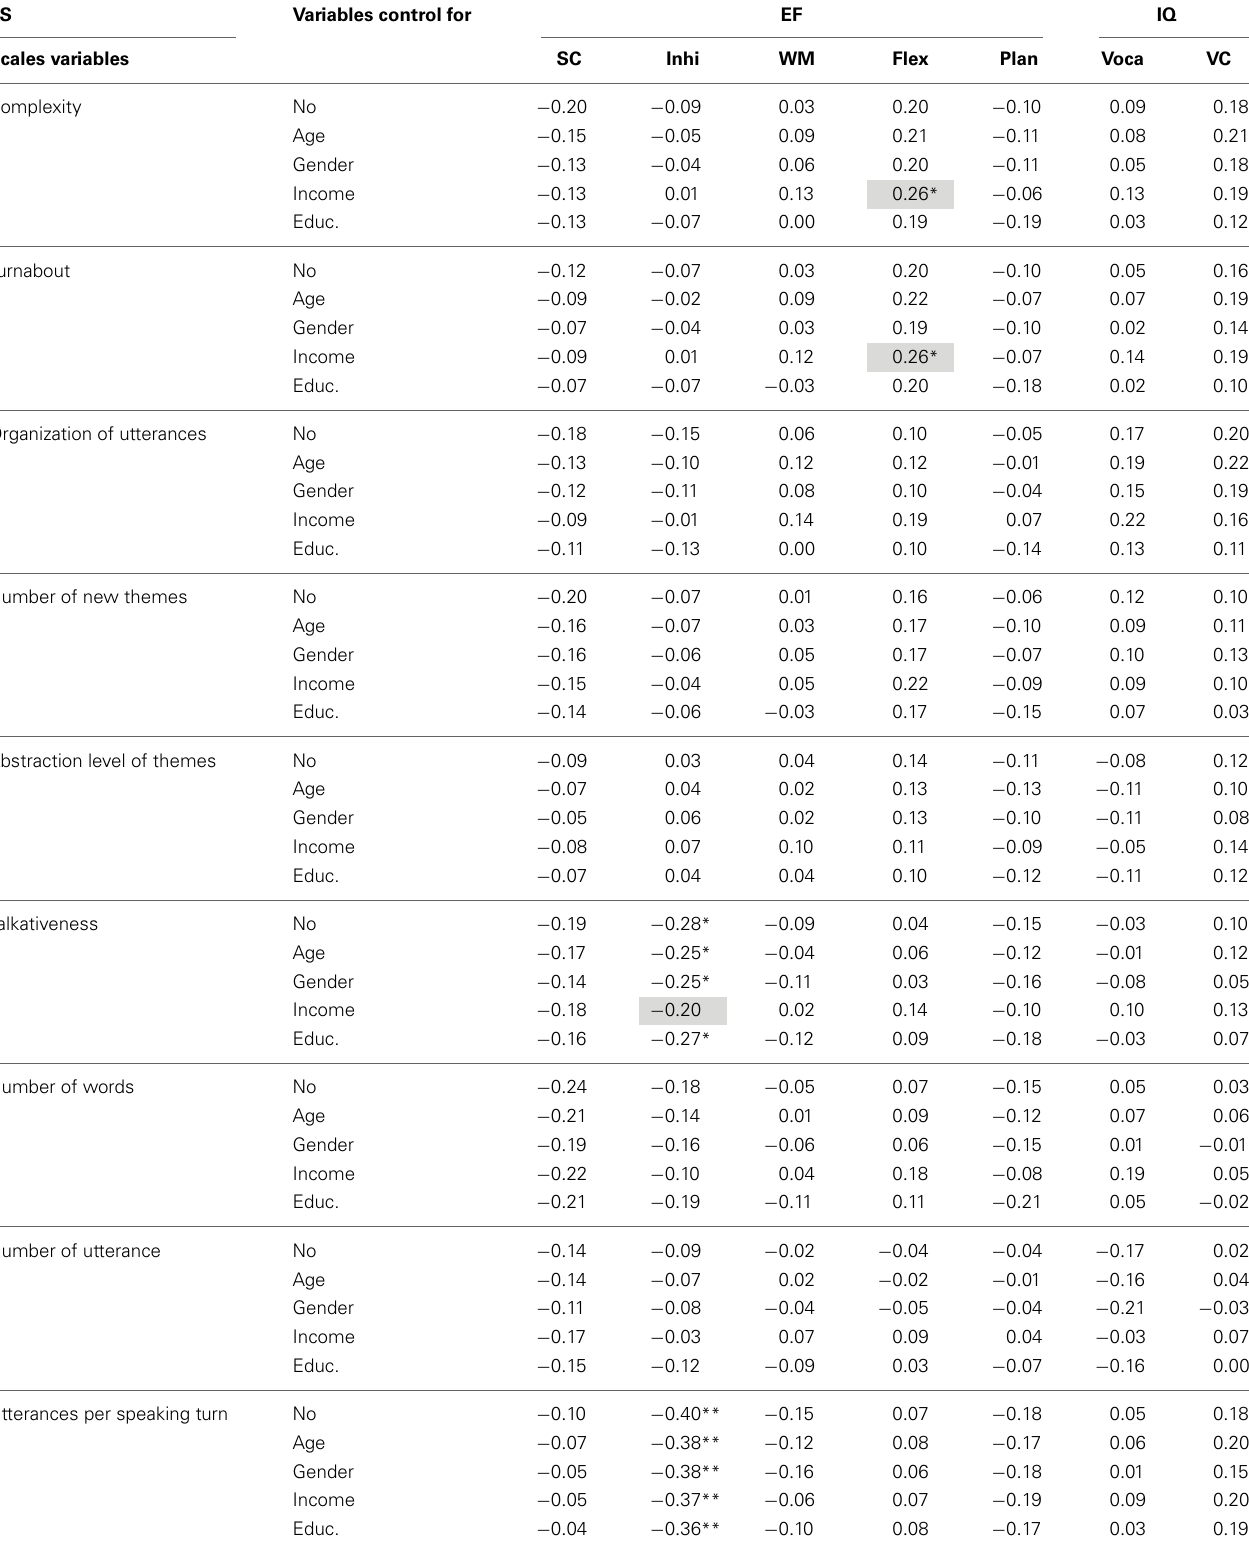
Table 6 | Partial Pearson correlations between pragmatics skills (PS) and executive functions (EF) and intellectual quotient (IQ) controlling for age, gender, income, and education of the mother. PS Variables control for Scales variables Complexity